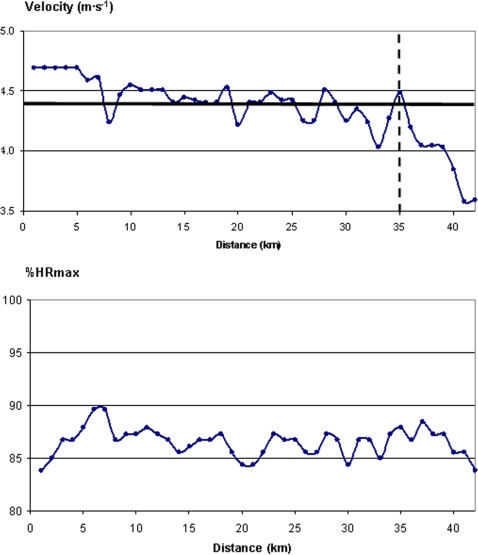
Running velocity (top) and % of maximal heart rate (%HRmax) (bottom) in a marathon runner who “hit the wall” (vertical dashed line) and decreased running velocity markedly after 35 km.Mean speed during the race is marked with a bold horizontal line. Note that %HRmax did not decrease until after a secondary decrease in pace at 39 km, suggesting that despite slowing after 35 km, he maintained effort until slowing down even more at 39 km.